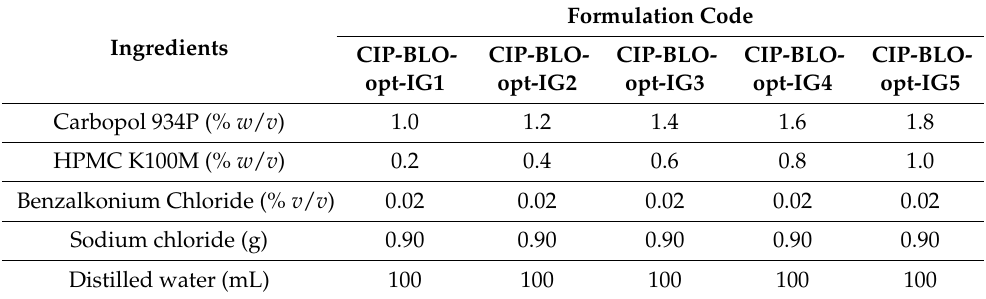
Table 5. Composition of in-situ